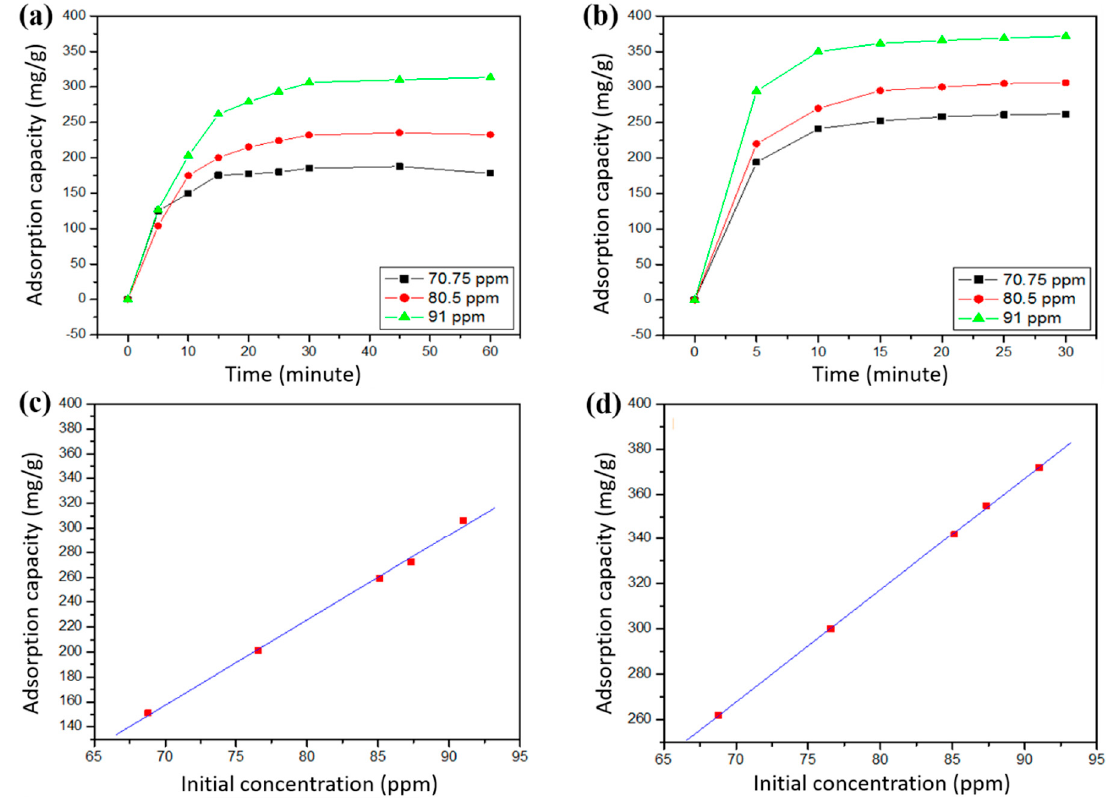
Figure 2. Effect of contact time on the adsorption capacity of ( a ) chitosan and ( b ) NK 80 C 20 ; effect of the initial concentration of Remazol Red (RR) on the adsorption capacity of ( c ) chitosan and ( d ) NK 80 C 20 .